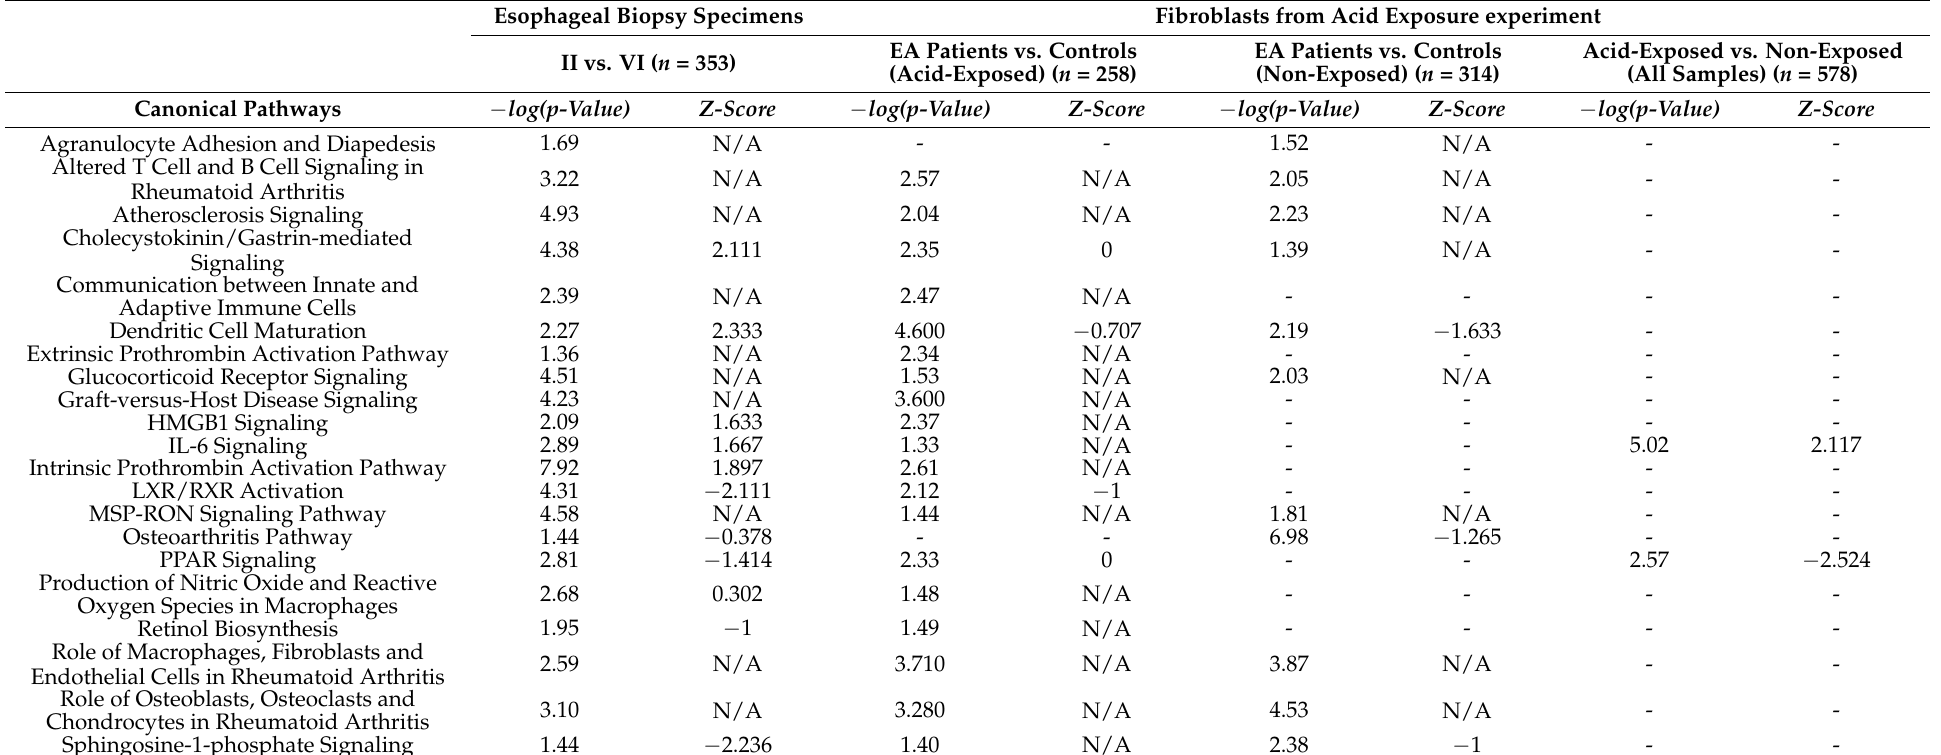
Table 1. Overlap between canonical pathways, significantly enriched by differentially expressed genes, in the esophageal biopsy specimens versus the acid-exposed and non-exposed fibroblasts. II = gastroesophageal junction (GEJ) samples from group A (esophageal atresia (EA) and Barrett’s esophagus (BE)), VI = GEJ samples from group C (BE-only). n = total number of canonical pathways significantly enriched by differentially expressed genes. N/A = not applicable, z-score could not be calculated. Grey box indicates that a pathway was not present in the results of that pathway